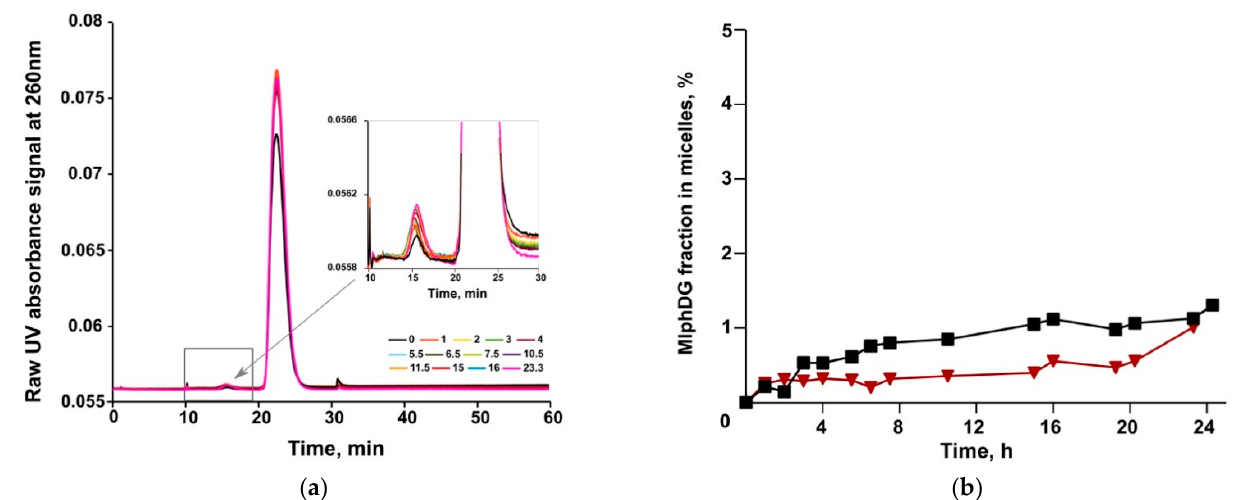
Figure 9. AF4/VWD elution profiles of MlphDG transfer from the ePC–MlphDG–PI liposomes to micelles taken at different time of incubation ( a ) and the amount of MlphDG (in percent to the amount injected in the liposomal formulation) transferred from liposomes to micelles ( b ).